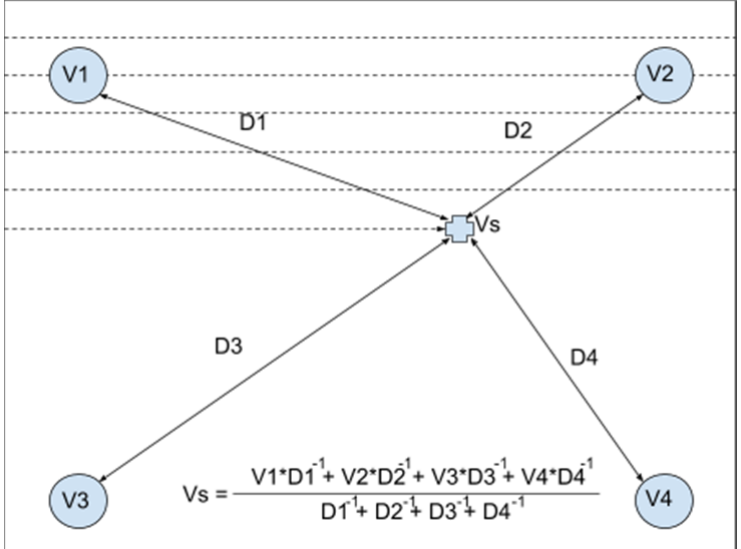
Figure 15. Interpolation method for 2D map